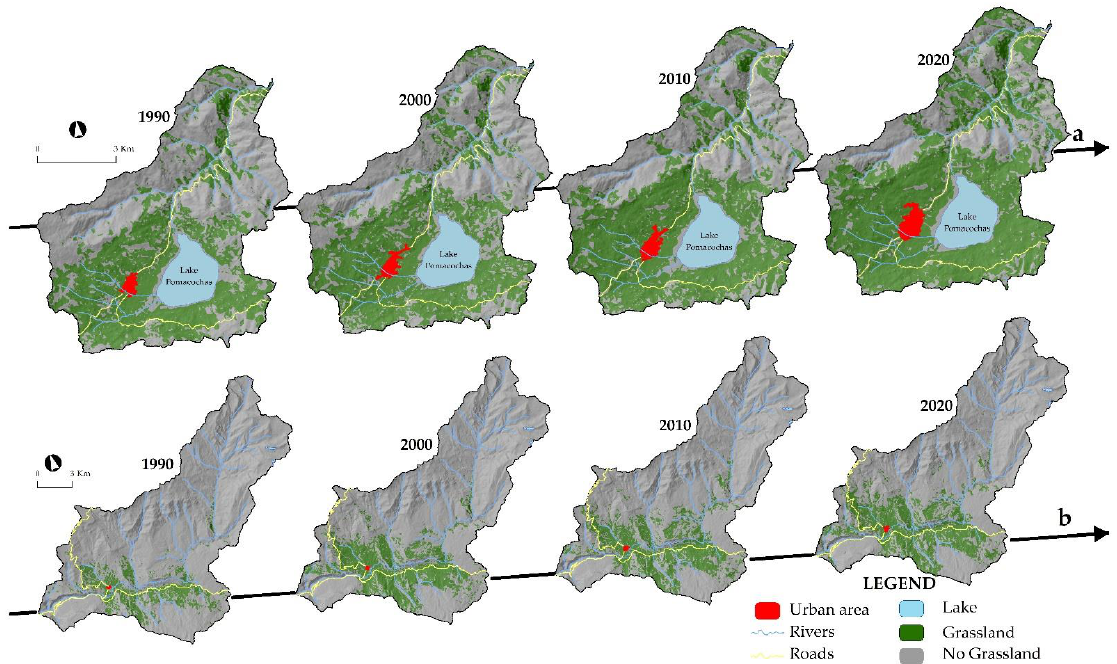
Figure 4. Maps of grassland dynamics from 1990 to 2020: ( a ) Pomacochas micro-watershed and ( b ) Ventilla micro-watershed. Statistical validation of the maps generated was achieved based on validation points for each micro-watershed, which allowed comparison of GA and Kappa (Figure 5). The